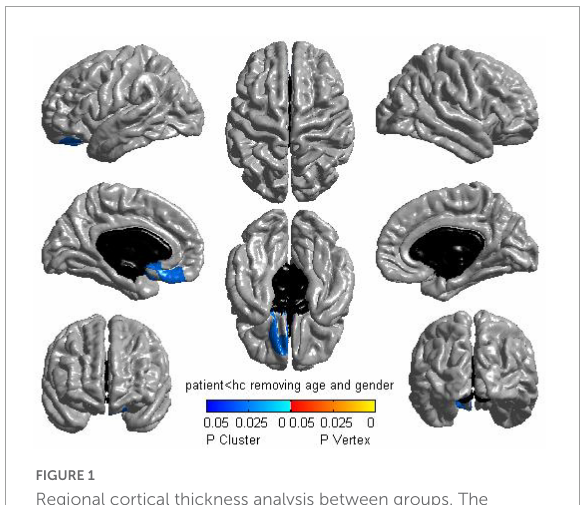
FIGURE1 Regional cortical thickness analysis between groups. The surface-based morphometry analysis highlighted a significant thickness reduction in the left medial orbitofrontal cortex for post-traumatic stress disorder (PTSD) participants compared with trauma-exposed non-PTSD subjects [1,994 vertices, P = 0.0265, corrected with random-field-theory